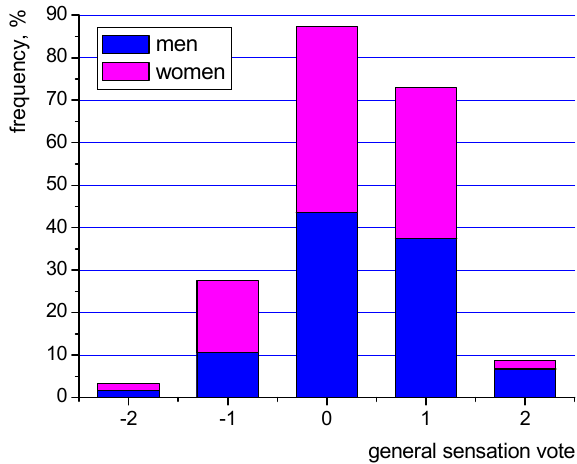
Figure 18. General sensation vote of the room occupants in both intelligent buildings based on 1369 questionnaires (description in the text).